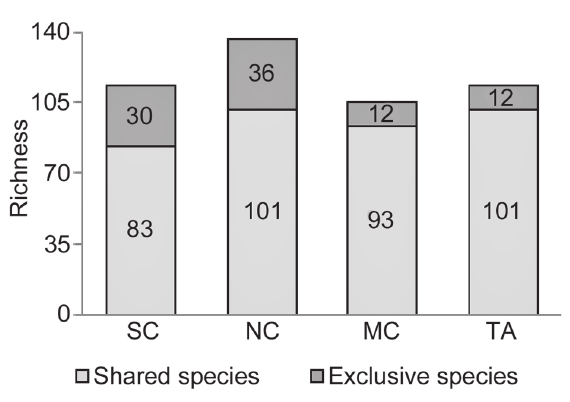
Figure 3 - Species richness per subregion registered for the grasslands of southern Brazilian coastal plain, indicating the number of exclusive species and number of species that were shared between two or more